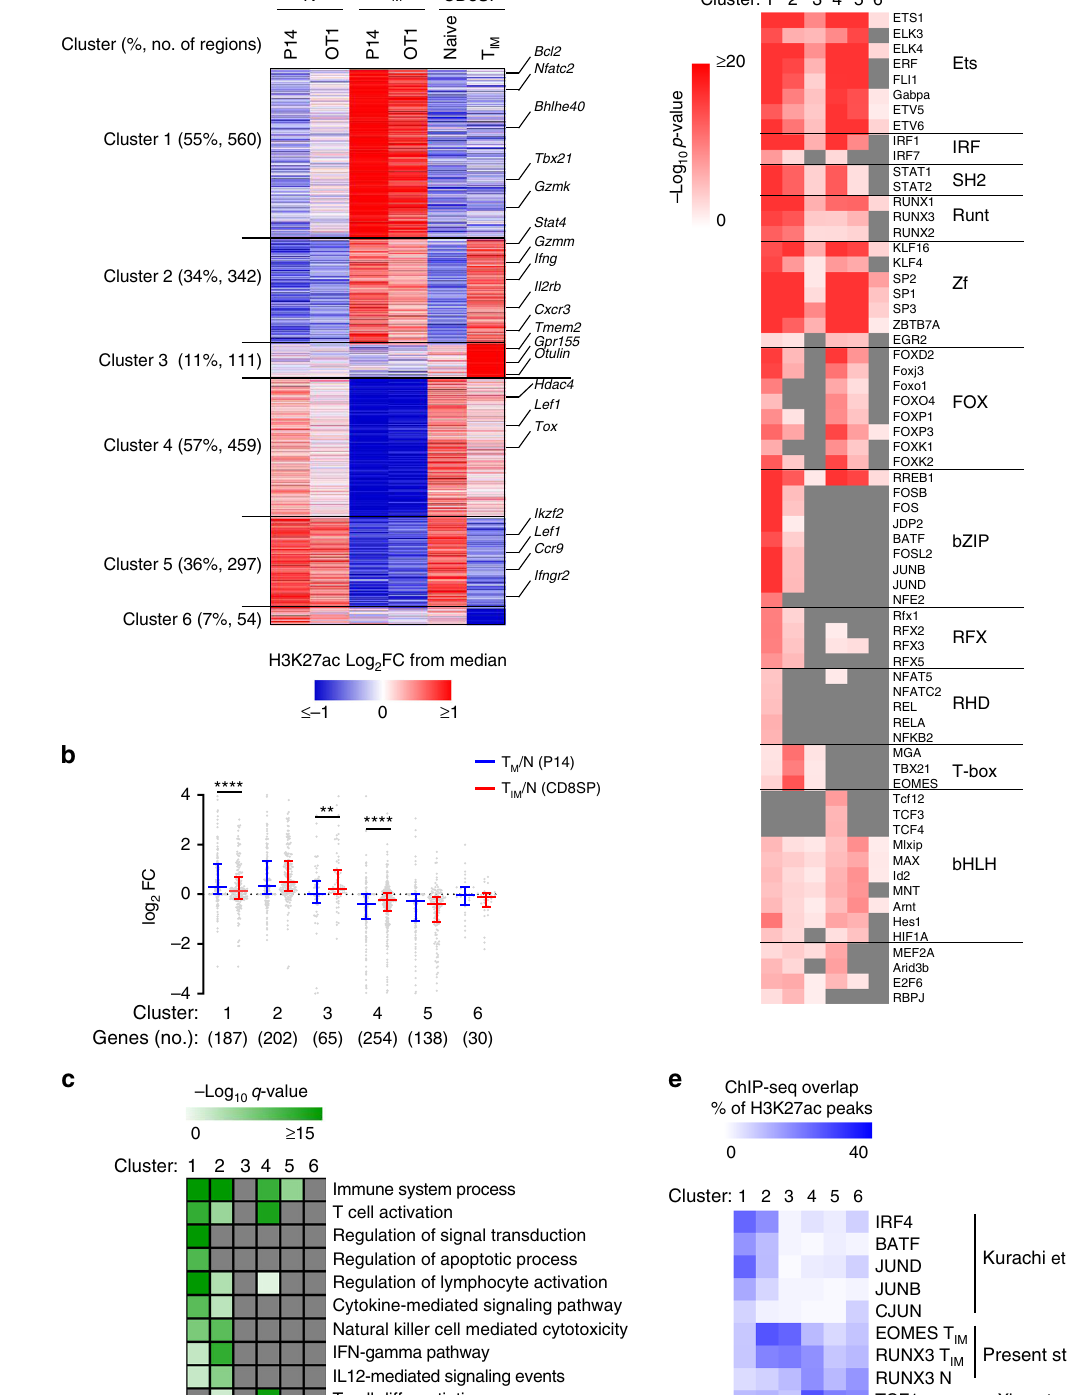
Regulation of signal transduction Regulation of apoptotic process Regulation of lymphocyte activation Cytokine-mediated signaling pathway Natural killer cell mediated cytotoxicity IFN-gamma pathway IL12-mediated signaling events T cell